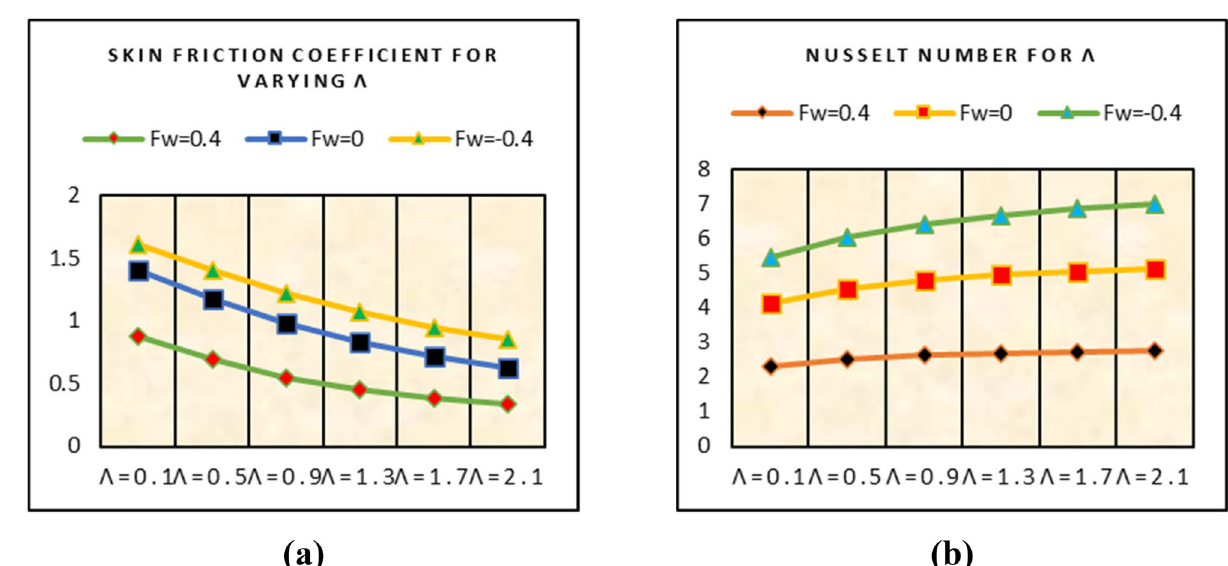
Figure 11. Impacts of (cid:31) on ( a ) shear stresses ( b ) nusselt